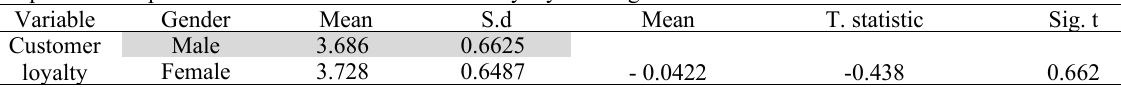
Independent samples t. test of difference in customer loyalty due to